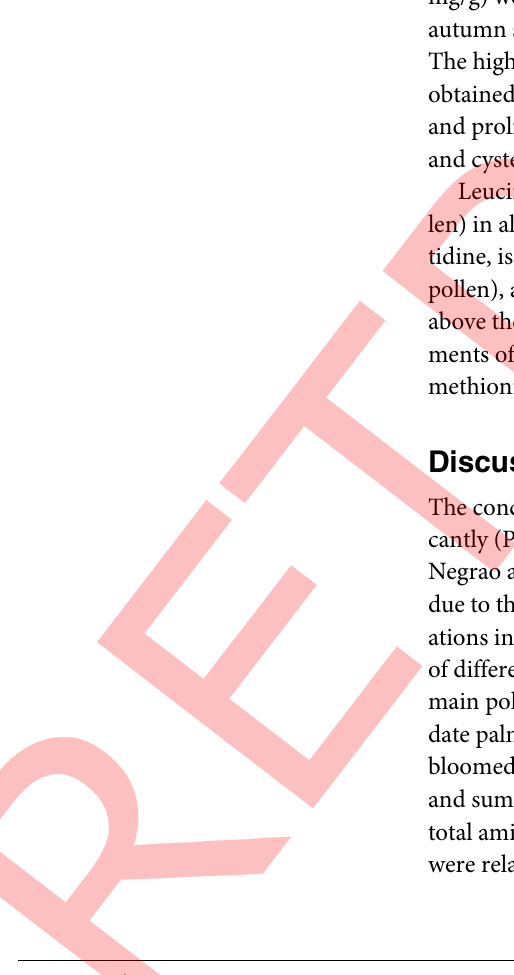
percentage (43.84%) were obtained from bee pollen collected during the winter season. Bee pollen collected during autumn had the lowest values of amino acids. The values of protein EAAI could be arranged as follows: autumn (62.36%) > summer (60.43%) > winter (59.64%) > spring (58.79%) (Table 3). Ten EAAs and 8 non-EAAs were found in bee pollen collected during all four seasons. The highest contents of leucine (12.85 mg/g), valine (10.26 mg/g), isoleucine (6.50 mg/g), and thre- onine (4.58 mg/g) were obtained from bee pollen collected during spring. The highest values mg/g) were obtained from bee pollen collected during winter. Bee pollen collected during